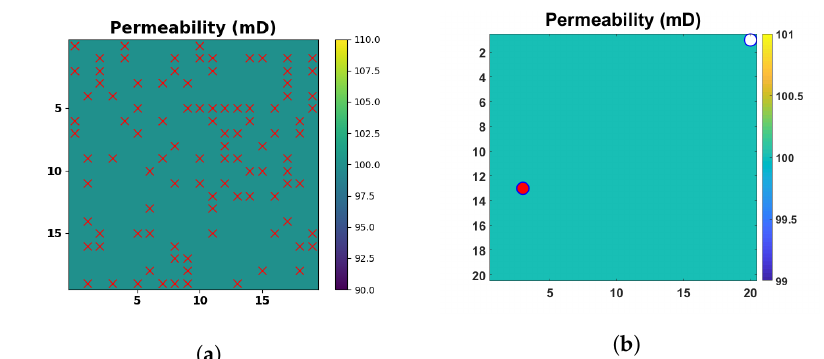
Figure 6. ( a ) Training samples of the producer well locations shown by red crosses. ( b ) Test case 1 well location at (3,13) in a homogeneous reservoir.